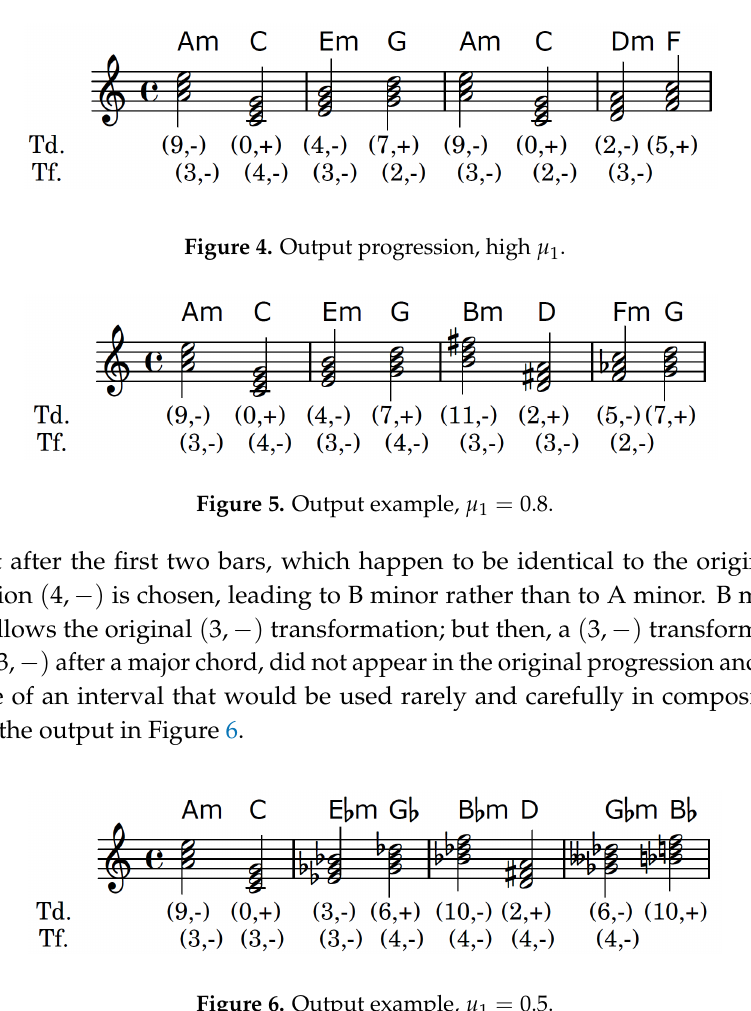
Figure 6. Output example, µ 1 =